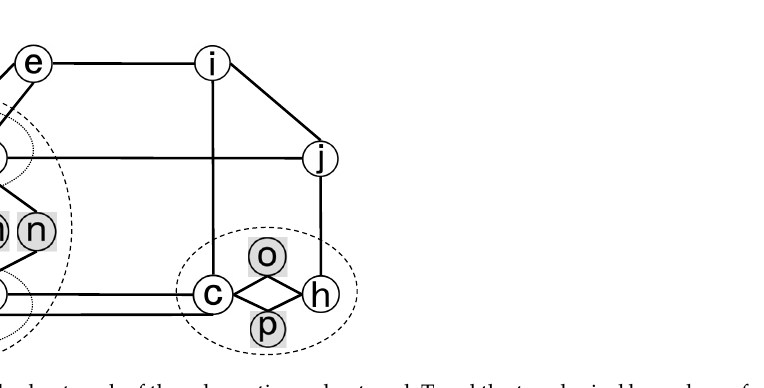
Figure 2. The dual network of the schematic road network T and the topological boundary of complex junctions depicted in Figure 1.